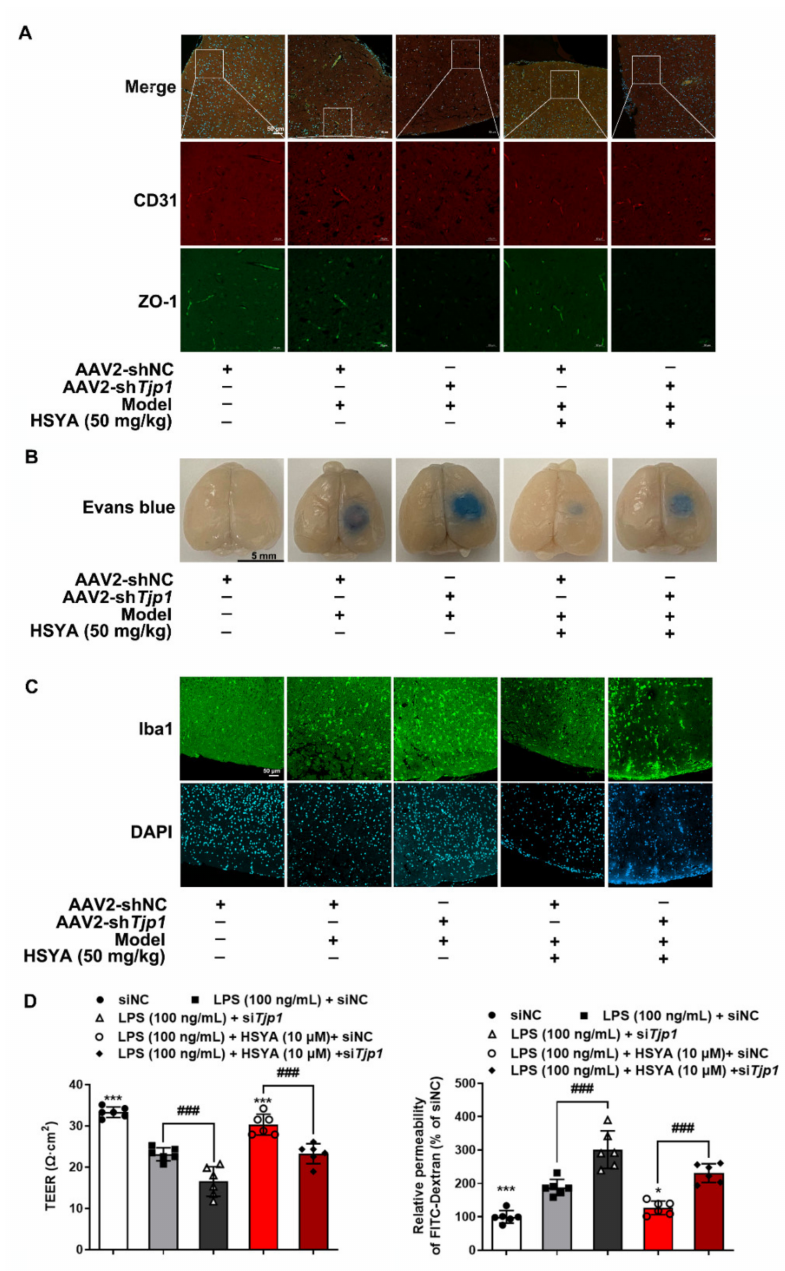
Figure 6. ZO-1 deficiency attenuated protective effects of HSYA during cerebral ischemic injury. Male C57BL/6J mice were injected with AAV2/br1-TIE-mir30-m- Tjp1 and AAV2/br1-TIE-NC (negative control) viruses to build ZO-1 deficiency mice. Additionally, the mice were administrated with HSYA for 3 consecutive days: ( A ) immunofluorescence staining of ZO-1 protein expression in the peri-infarct zones of brain tissue (scale bar: 50 µ m). Green: CD31, red: ZO-1; ( B ) Evans blue staining was used to observe the permeability of blood–brain barrier in mouse brain tissue. After injection of 2% Evans blue for 2 h, the brain tissue of the mice was removed and photographed; ( C ) immunofluorescence of Iba1 in the peri-infarct zones of brain tissue (scale bar: 500 µ m); ( D ) bEnd.3 cells were transfected with siRNA against ZO-1 (si Tjp1 ) or control siRNA (siNC) and then treated with HSYA in the presence of LPS. TEER values, and the absorbance of FITC–dextran across the bEnd.3 monolayer cells were measured. All data are presented from five independent experiments. ### p < 0.001 vs. indicated group, * p < 0.05, *** p < 0.001 vs. LPS